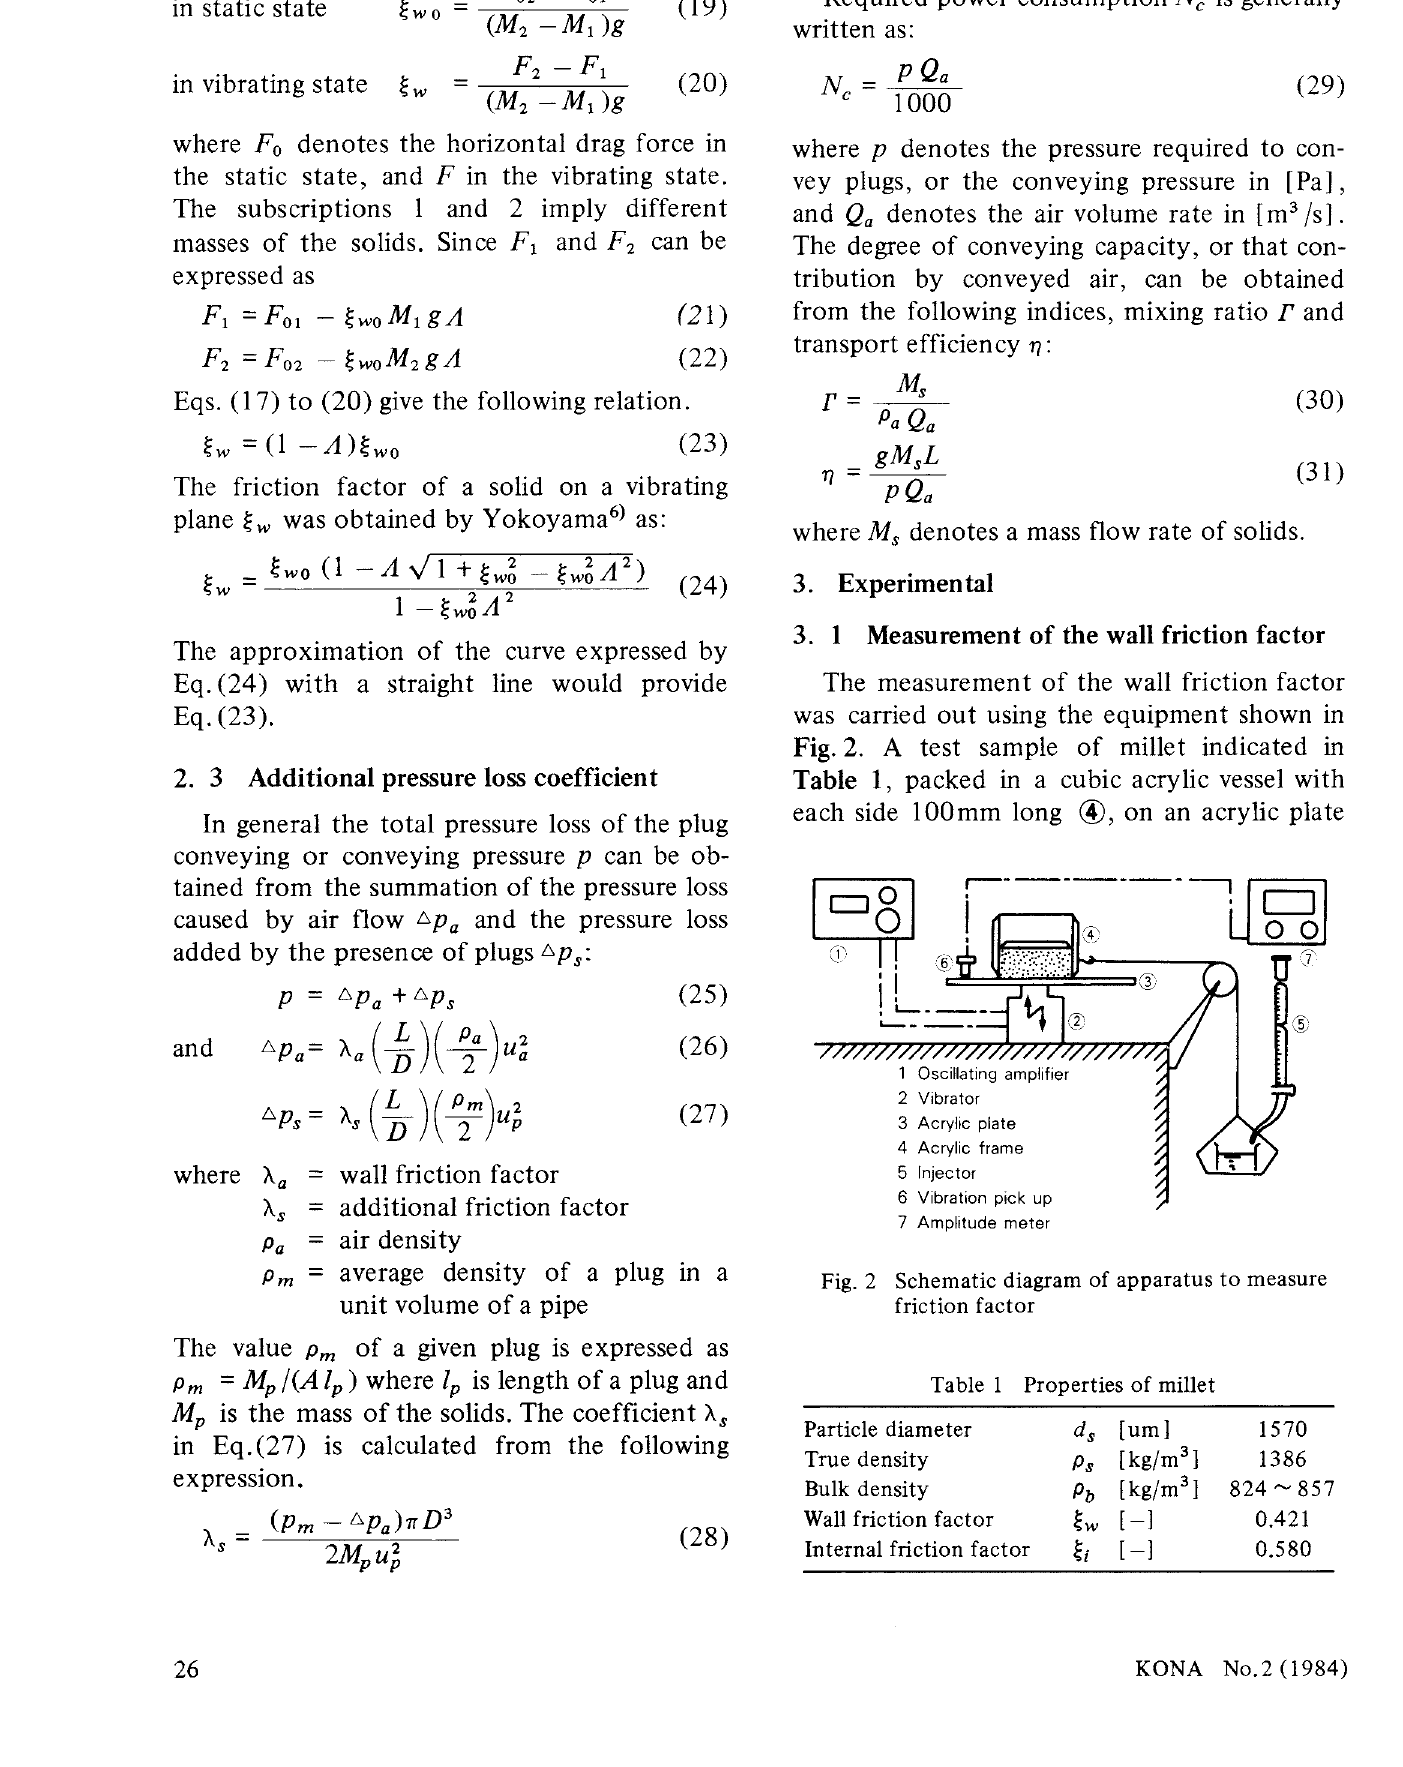
Fig. 2 Schematic diagram of apparatus to measure friction